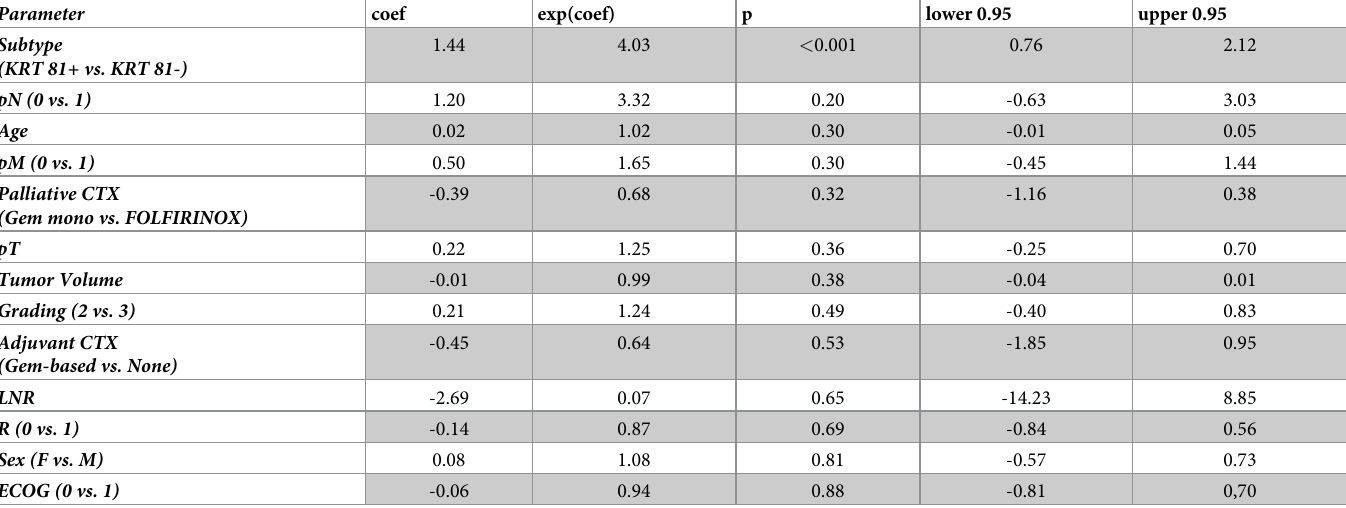
Fig 2. Patients with a KRT81+ subtype experienced significantly diminished overall survival. https://doi.org/10.1371/journal.pone.0218642.g002 Table 1. Multivariate Cox proportional hazards analysis results of clinical